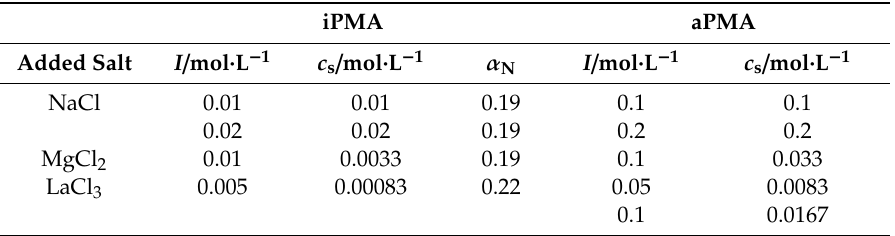
Table 1. Final ionic strengths ( I ) and corresponding molar concentrations ( c s ) of added salt